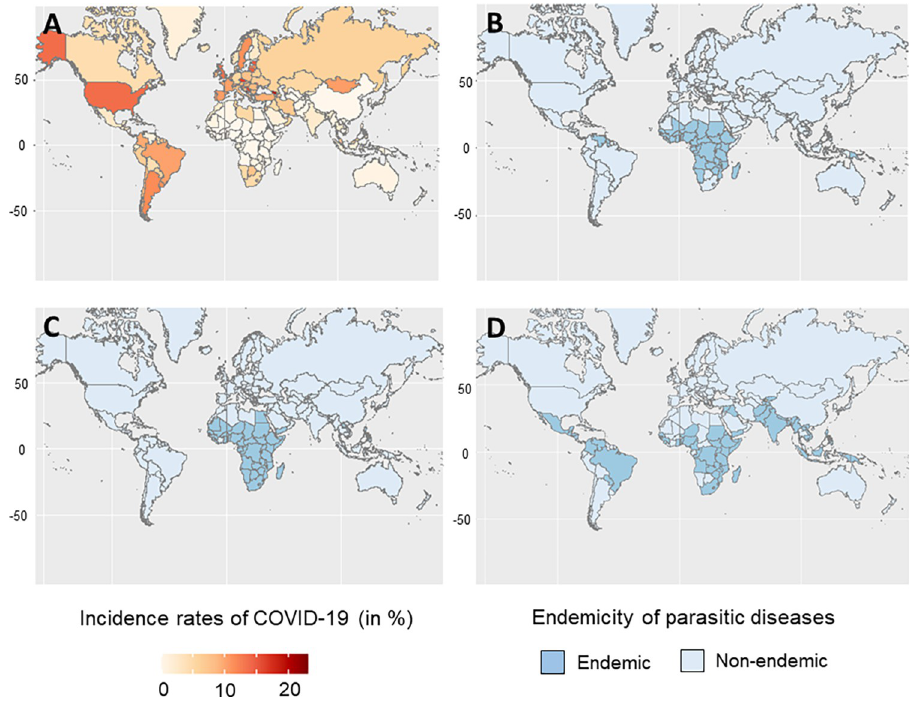
Fig 2. Differential distribution of COVID-19 and parasitic diseases. (A) COVID-19; (B) malaria; (C) schistosomiasis; (D) soil-transmitted helminthiasis. The map data named “world” in the R software package “maps” was employed to draw base maps in the figure. (https://rdocumentation.org/packages/maps/versions/3.4.0).